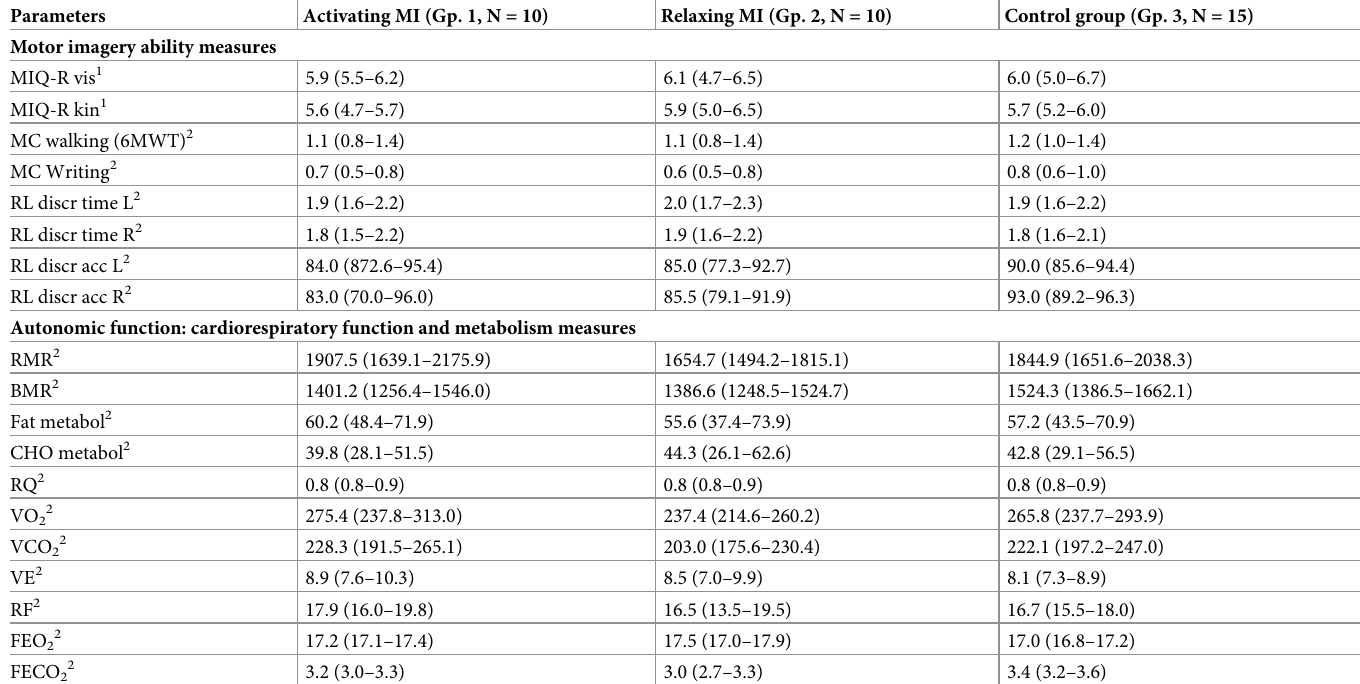
Table 2. Motor imagery ability and autonomic function at